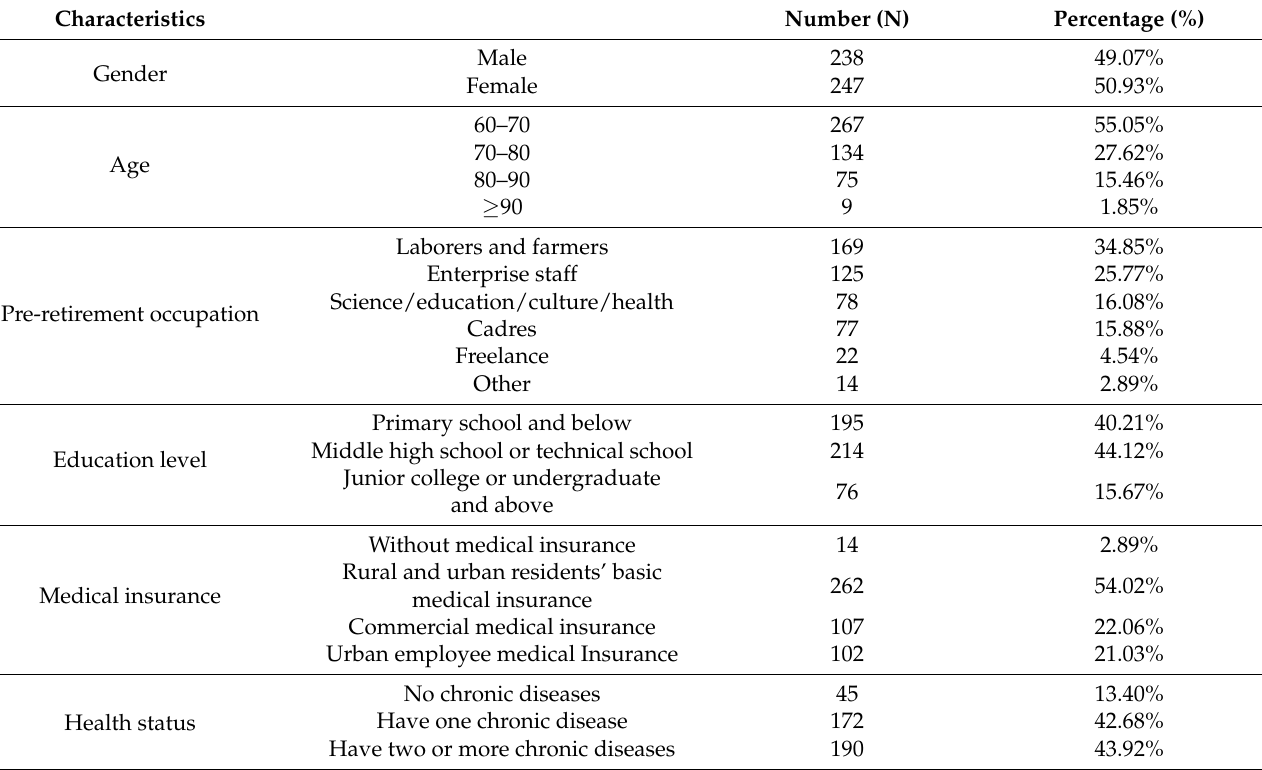
Table 1. Basic characteristics of respondents in this study.